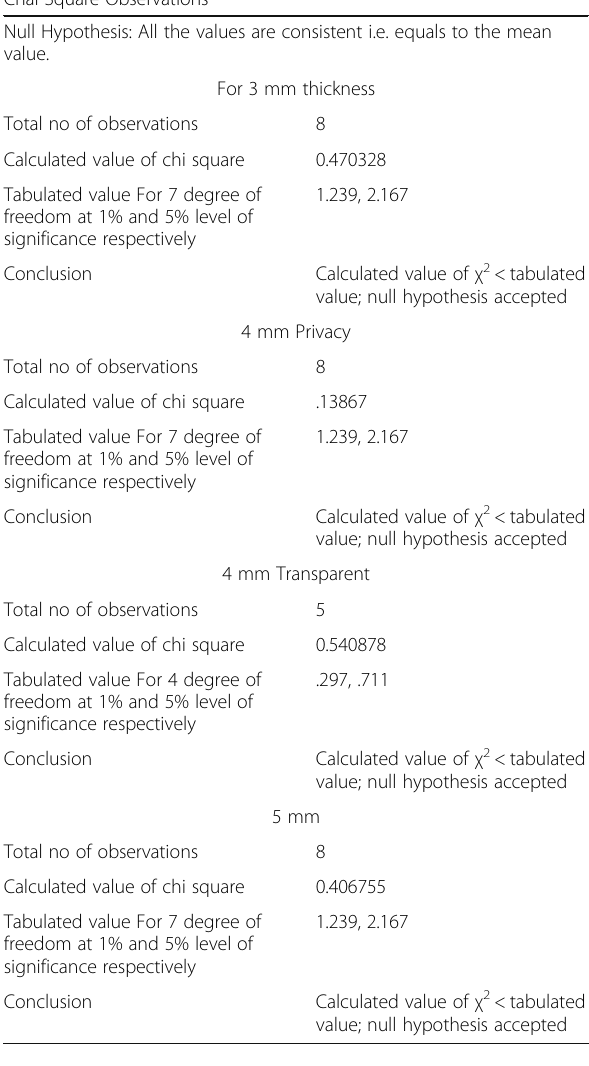
Table 4 Observations of the Chi Square Test